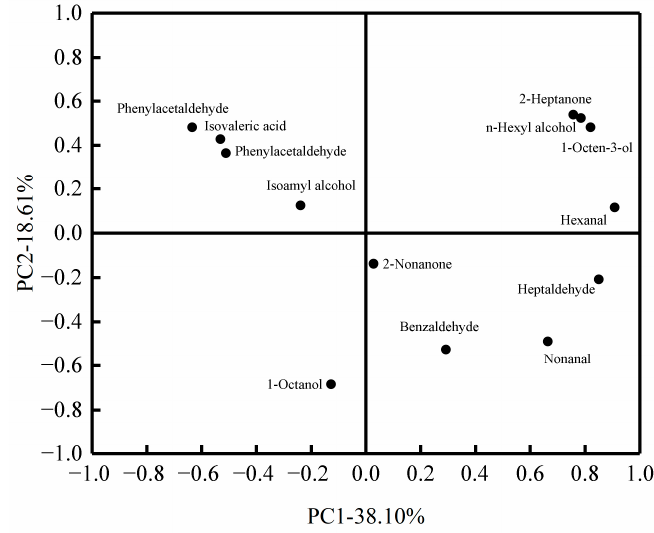
Figure 12. Principal component loading diagram of key flavor compounds in beef under different low-temperature storage methods.